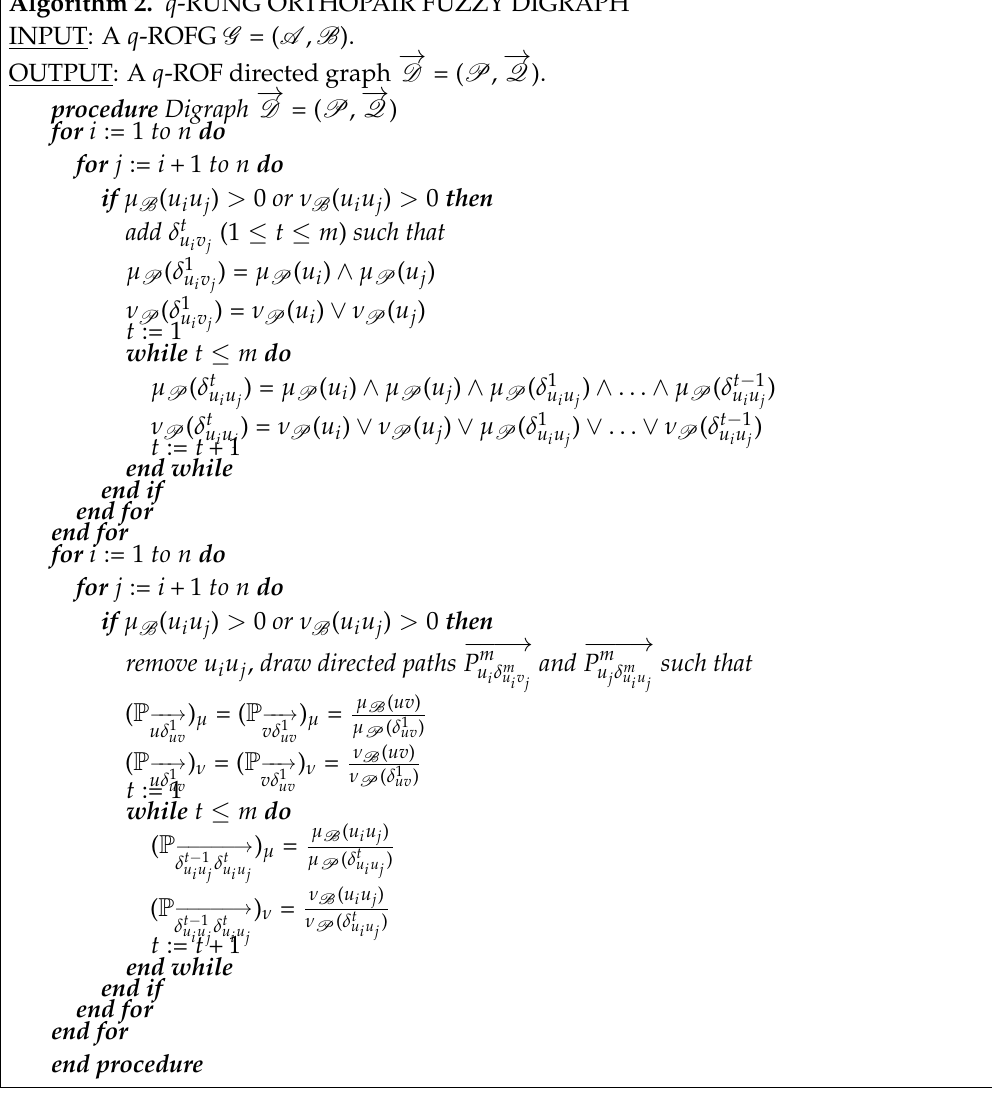
Algorithm 2. q -RUNG ORTHOPAIR FUZZY